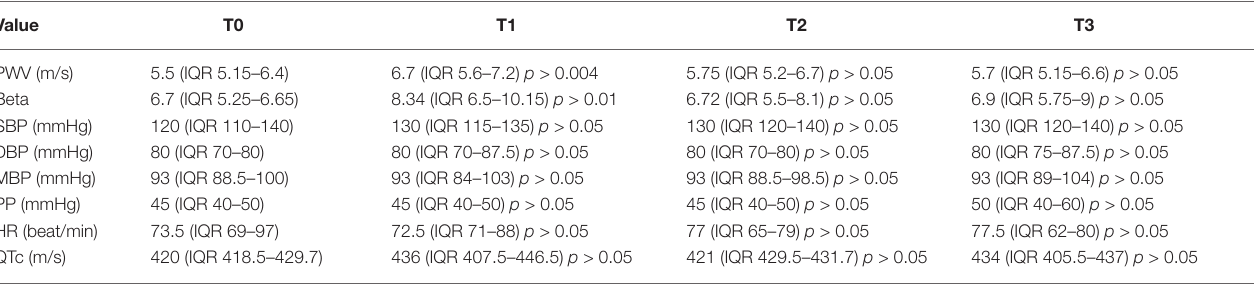
TABLE 2 | Comparison of various parameters at different time of evaluation with Friedman test (value of p refers to the changes that occur in the various times compared to the